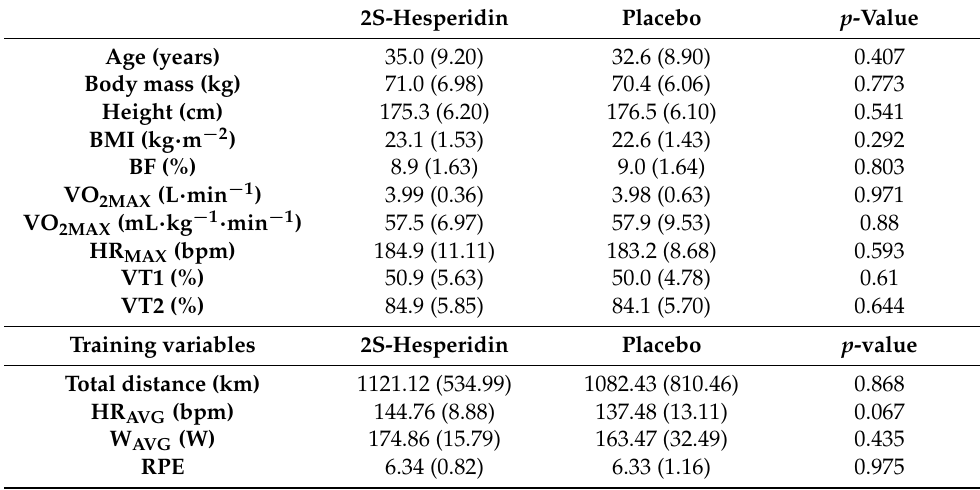
Table 1. Baseline general characteristics and training variables of the cyclists. 2S-Hesperidin